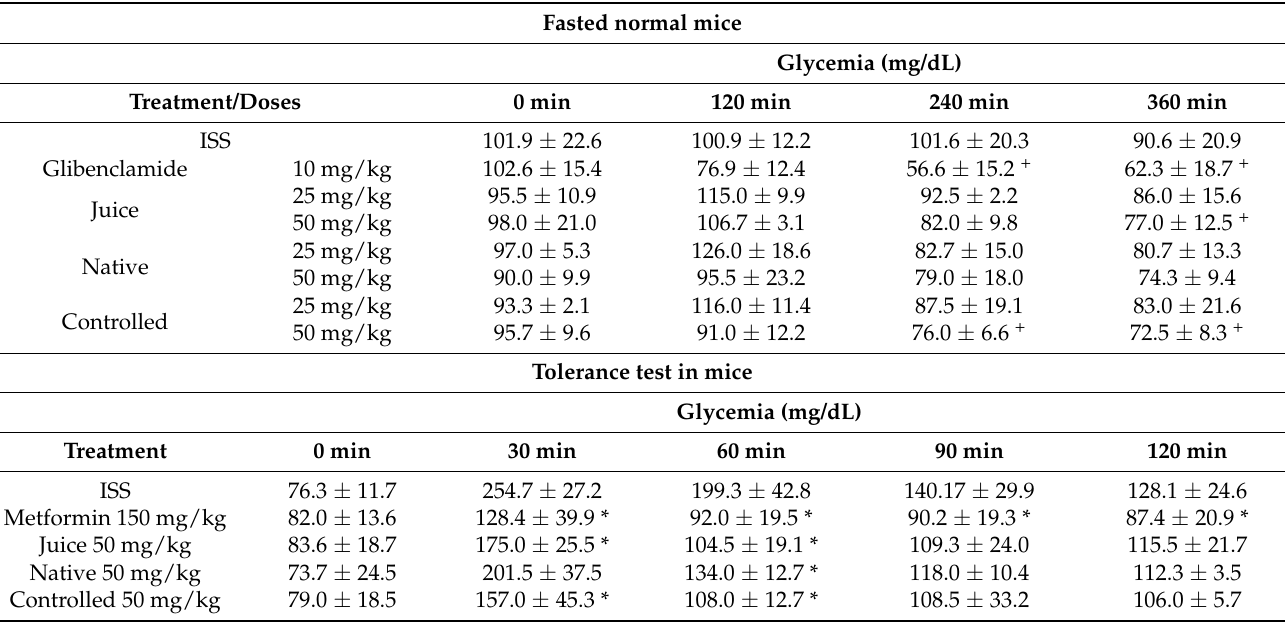
Table 6. Effect on glycemia of the juice and samples at 48 h of native and controlled fermentations in: fasted normal mice and oral glucose tolerance test in